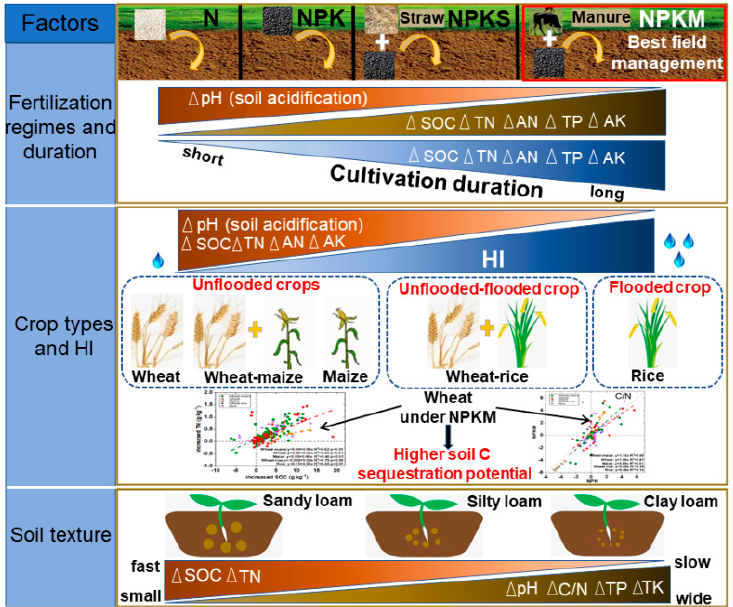
Figure 11. Fertilization − induced changes of soil chemical properties according to fertilizer regimes, crops, cultivation duration, climatic conditions, and soil texture. HI: humidity index =MAP/(MAT +10), ∆ : percent change. SOC: soil organic carbon. C/N: organic carbon − nitrogen ratio. TN: total nitrogen. AN: alkali − hydrolysable nitrogen. TP: total phosphorus. AP: available phosphorus. TK: total potassium. AK: available potassium. MAT, mean annual temperature. MAP, mean annual pre- cipitation.